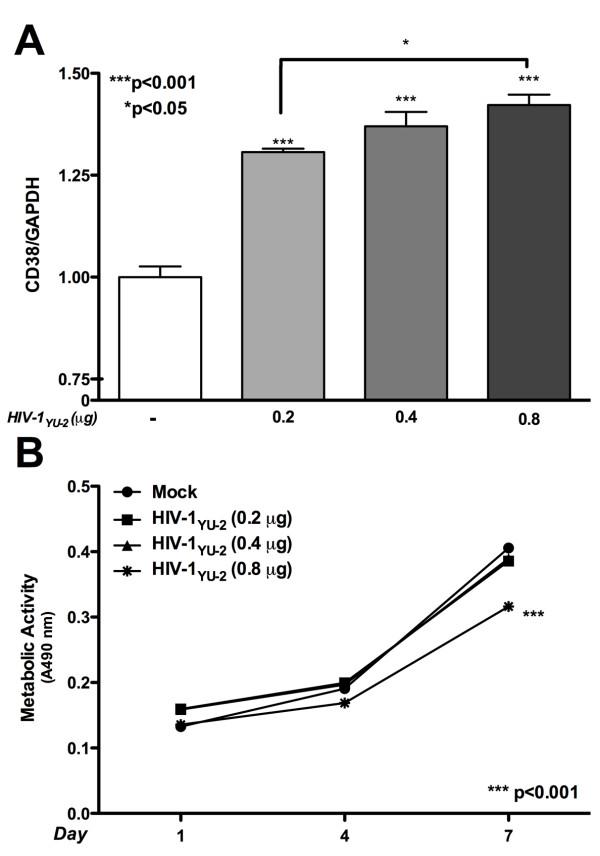
CD38 mRNA expression corresponds with viral gene expression in HIV-1YU-2 transfected astrocytes. Astrocytes were transfected with a dose of HIV-1YU-2 plasmid 0.2, 0.4 and 0.8 μg/1.5 million cells and assayed for CD38 expression and cell viability. (A) Twenty four hours post-HIV-1YU-2-transfection, CD38 expression increased significantly in a dose-dependant manner a measured by RT-PCR (p < 0.001). (B) Metabolic activity levels were unchanged by HIV-1YU-2 transfection at 0.2 and 0.4 μg as compared to mock. However, at 0.8 μg metabolic activity was significantly reduced at 7 day (p < 0.001). In subsequent experiments astrocytes were transfected with 0.3 μg and mRNA and protein levels were assayed at day five, to ensure viability of HIV-1YU-2-transfected astrocytes was not compromised during the experimental time course.